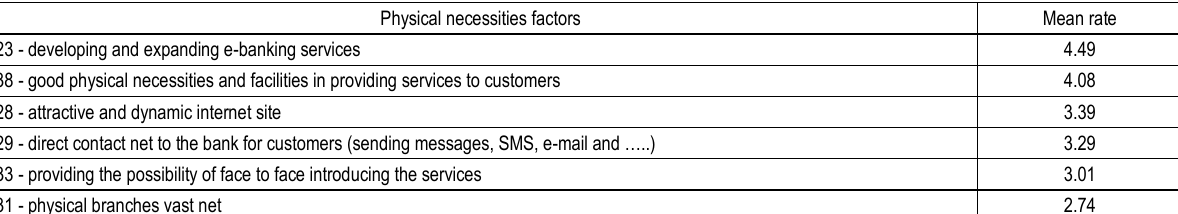
Table 8. Results of mean rate of physical necessities factors based on priority